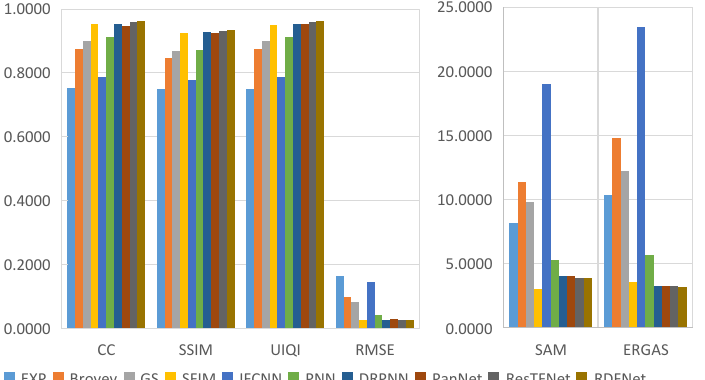
Figure 12. Quantitative evaluation metrics of the Landsat-8 training dataset with reduced